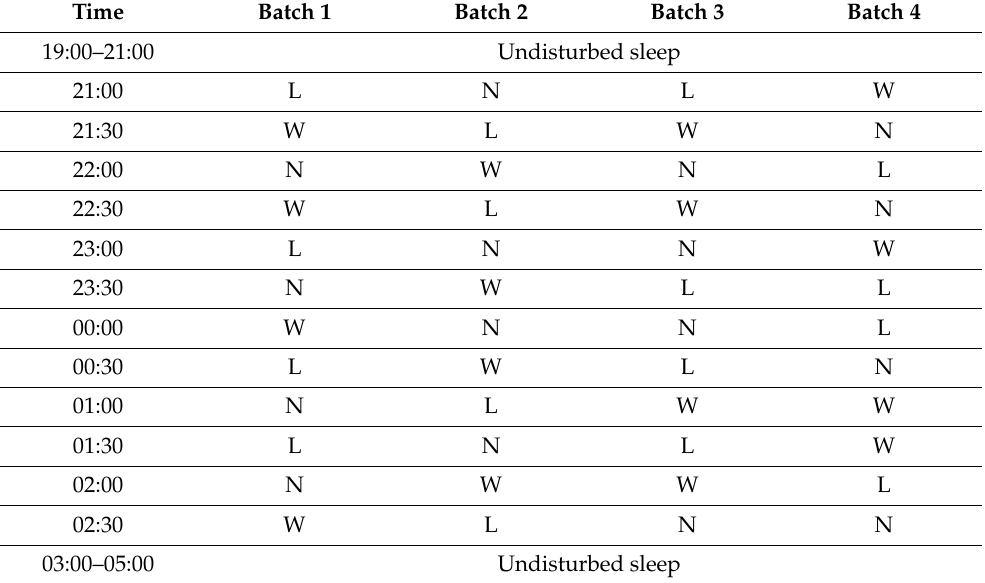
Table 3. Schedule for sleep disruptor application (incomplete Latin square) during lights off. Each disruptor was applied for 5 min each at the time shown (W = wind, L = light and N =